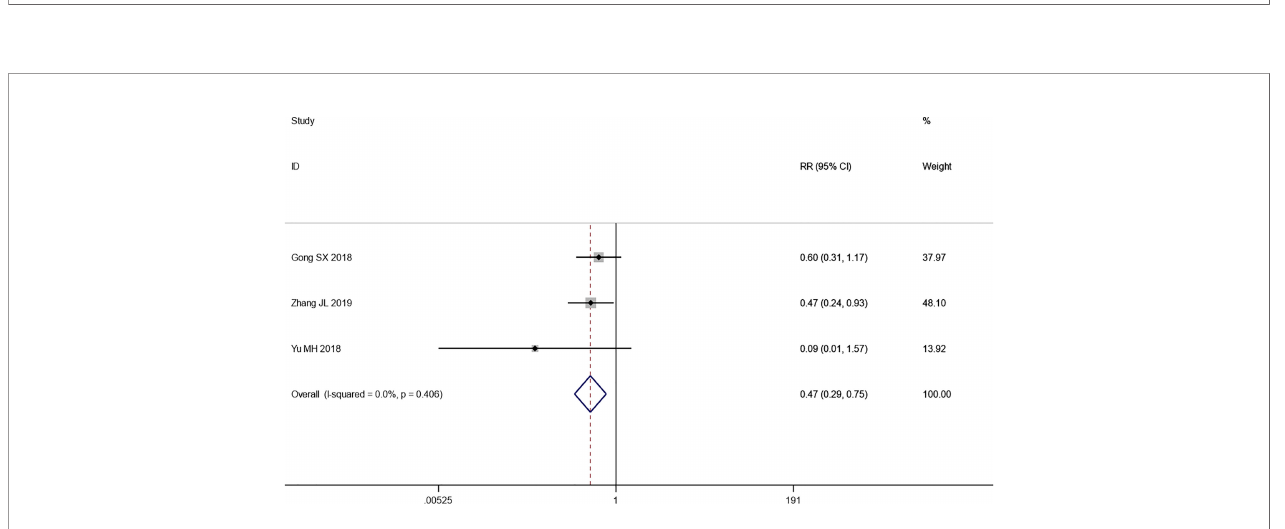
FIGURE 7 | Forest plot of the meta-analysis of immune function indicators including CD3 + T, CD4 + T, CD8 + T, and CD4 + /CD8 + T cells between the intervention group and the control group.